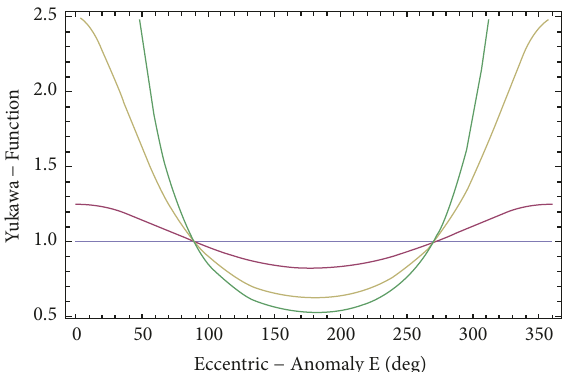
Figure1:Plotofthe“Yukawafunction”forellipticalorbitsofvarious eccentricitiesandeccentricanomalyduringonefullblue e =0.01,red e = 0.205, olive green e = 0.6, green e = 0.9.